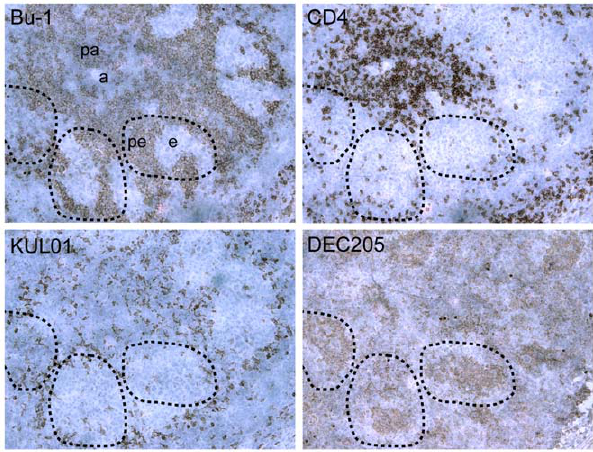
Figure 4. DEC205 and CD83 expressing cells in the spleen of a MDV infected bird. The four panels show a set of serial sections of the same area from the spleen of a juvenile bird five days after infection with Marek’s disease virus. The sections are stained with antibodies recognising the indicated molecules. Bu-1 revealing B cells and CD4 & CD8 revealing T cells. DEC205 is detected using the antibody FG9 and CD83 using GE8. Labelled features are artery (a) and germinal centre